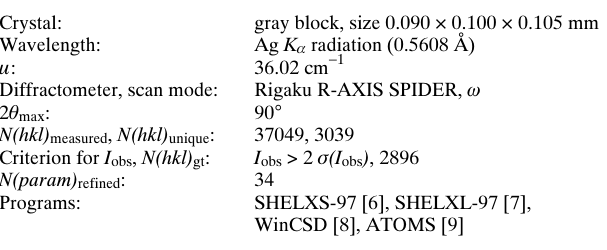
Table 1. Data collection and handling.